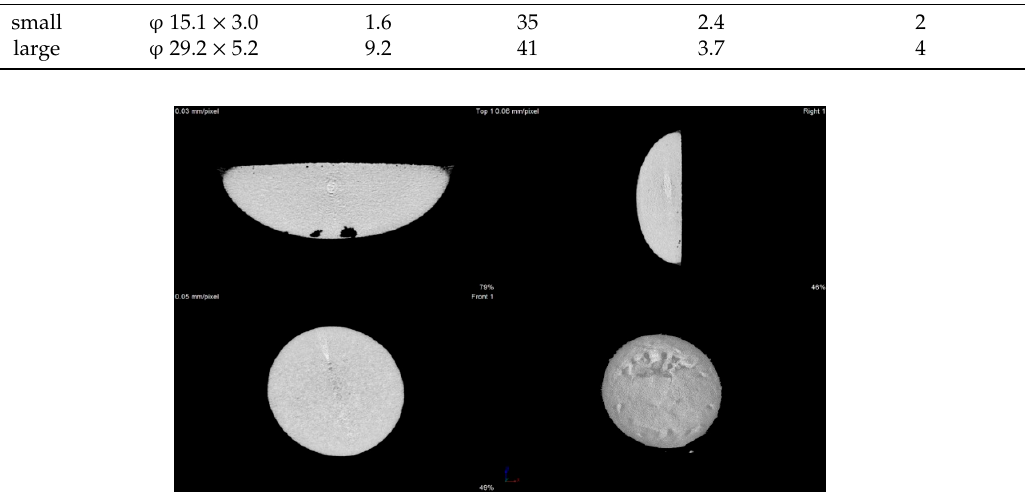
Figure 6. X-ray micro tomography of large droplet after solar melting: cuts in X, Y, Z planes and 3D picture of droplet. Final porosity 3.7%. Table 1. Geometry, porosity and final porosity of the investigated titanium samples.